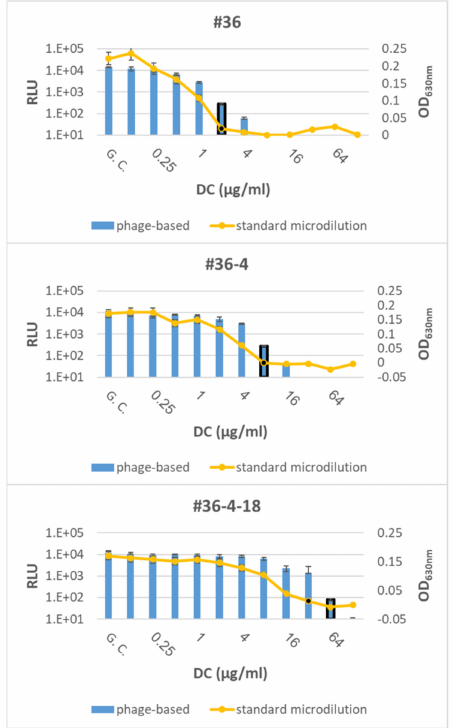
Figure 3. Phage-based AST for Kimberley53 ∆ 70 ∆ 10 derivatives with reduced susceptibility to doxycycline. Three Kimberley53 ∆ 70 ∆ 10 derivatives with reduced susceptibility to doxycycline (DC) (see Table 1) were suspended in MHB, diluted to ~5 × 10 5 CFU/mL and tested by the phage-based AST at 7 h of doxycycline exposure (blue bars) and by the standard microdilution test (yellow curve). The MIC values obtained by the phage-based AST are marked by a black frame around the relevant bar, and the MIC values obtained by the microdilution test are marked by a black dot. Values are the mean of three triplicate wells in the same experiment (error bars represent the standard